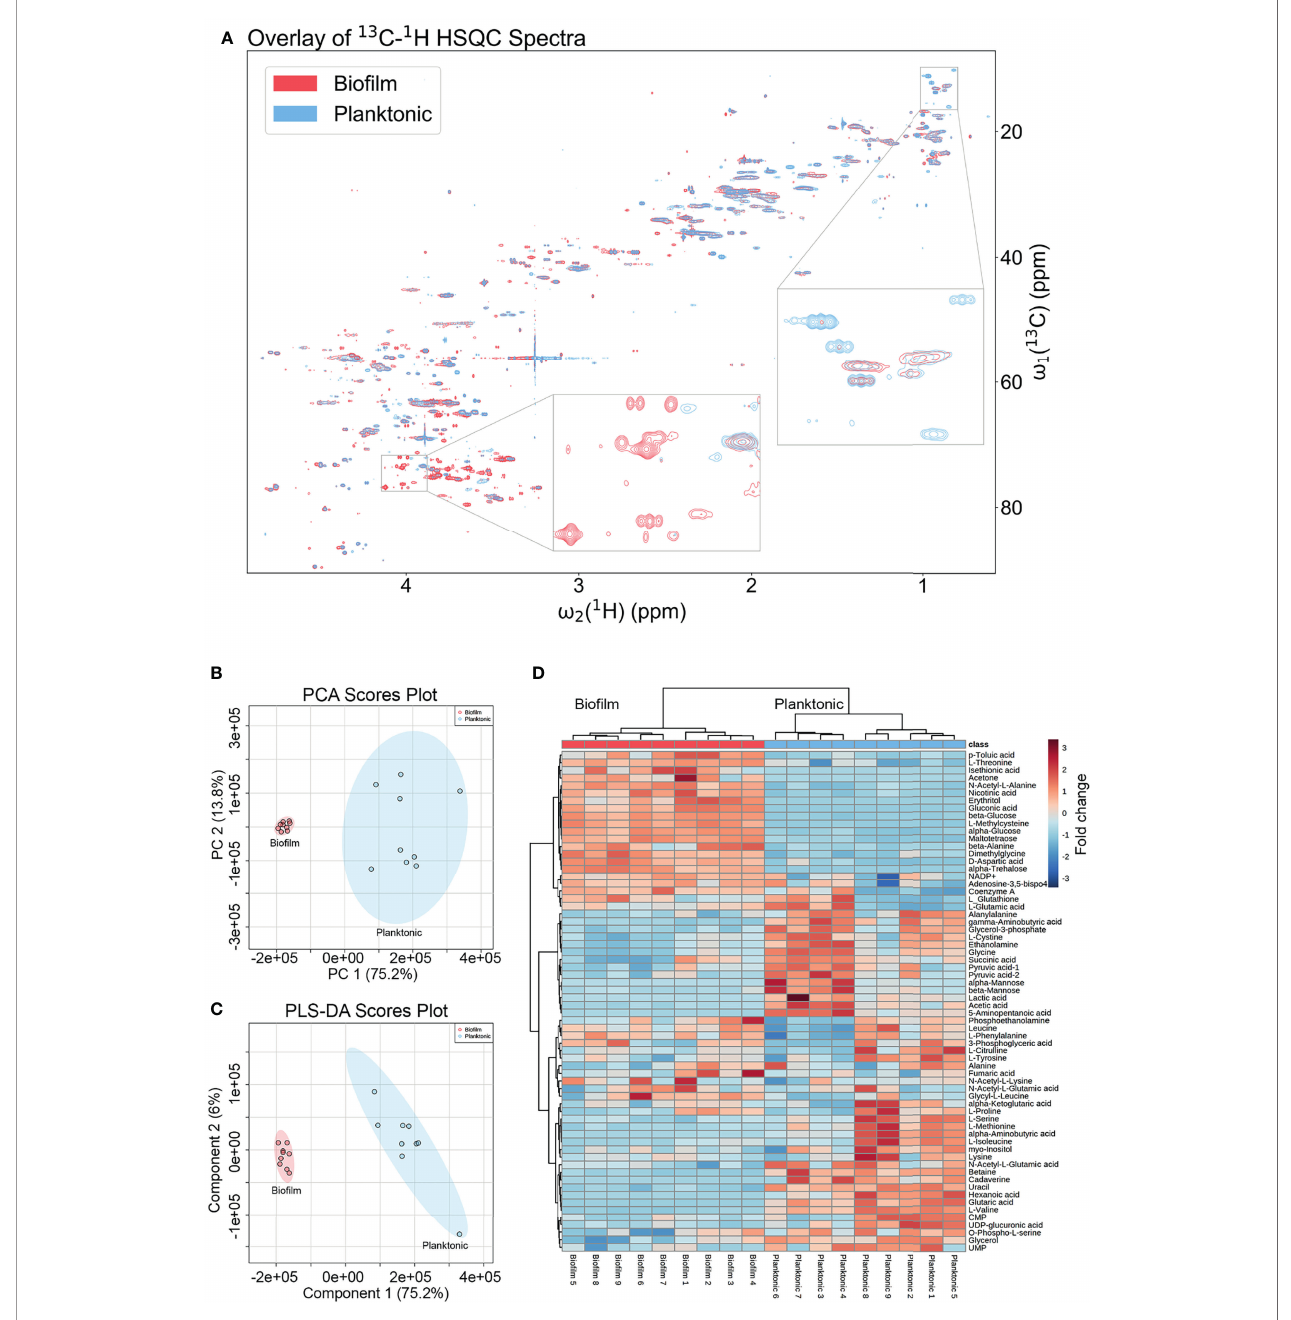
FIGURE 2 | Metabolomics data analysis shows many unique metabolic differences between the bio fi lm and planktonic phenotypes. (A) Overlay of a representative region of the 2D 13 C- 1 H HSQC spectra of a representative bio fi lm (red; bottom) and planktonic (blue; top) culture with select regions enlarged exemplifying peaks unique to each growth mode. Statistical analysis of metabolomics data distinguishes between bio fi lm and planktonic cohorts. Two- dimensional score plots for (B) principal component analysis (PCA) and (C) partial least squares discriminant analysis (PLS-DA) of bio fi lm (red) and planktonic (blue) sample cohorts (n=9) based on quantitation of identi fi ed metabolites show clustering of sample cohorts with no overlap of the ellipses (ellipses represent 95% con fi dence intervals), displaying good separation between and repeatability within cohorts. The heatmap (D) uses hierarchical clustering by Ward ’ s method and Euclidean distance to accurately cluster samples into their respective cohorts and the color scale shows metabolite fold changes between